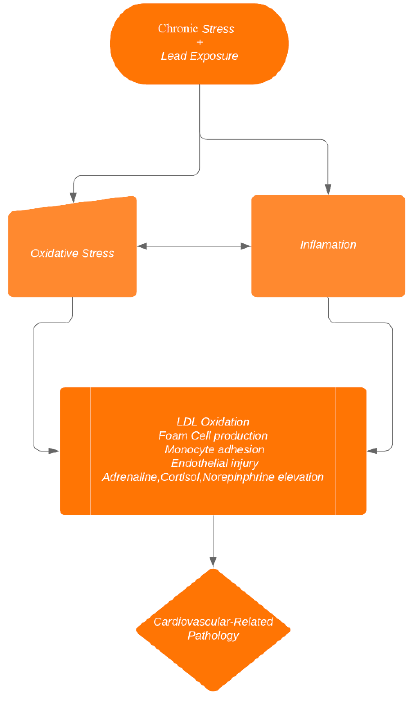
Figure 1. Mechanisms of stress-induced cardiovascular dysfunction among the lead-exposed.